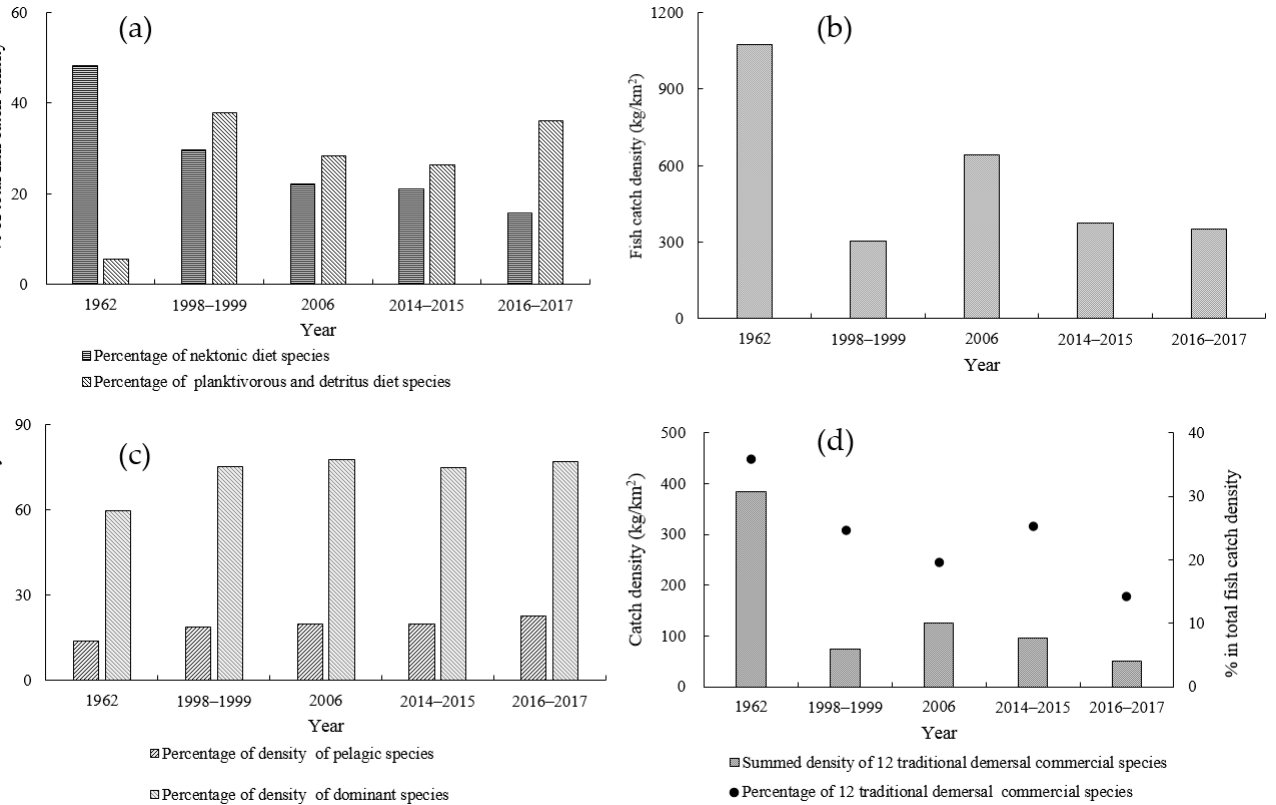
Figure 3. Interdecadal changes in the percentages of density of the species with nektonic diet and planktivorous and detritus diet ( a ), annual averaged catch density of fishes ( b ), the percentages of density of pelagic species and dominant species ( c ), and the summed density for the 12 traditional demersal commercial fishes ( d ) in the Beibu Gulf.